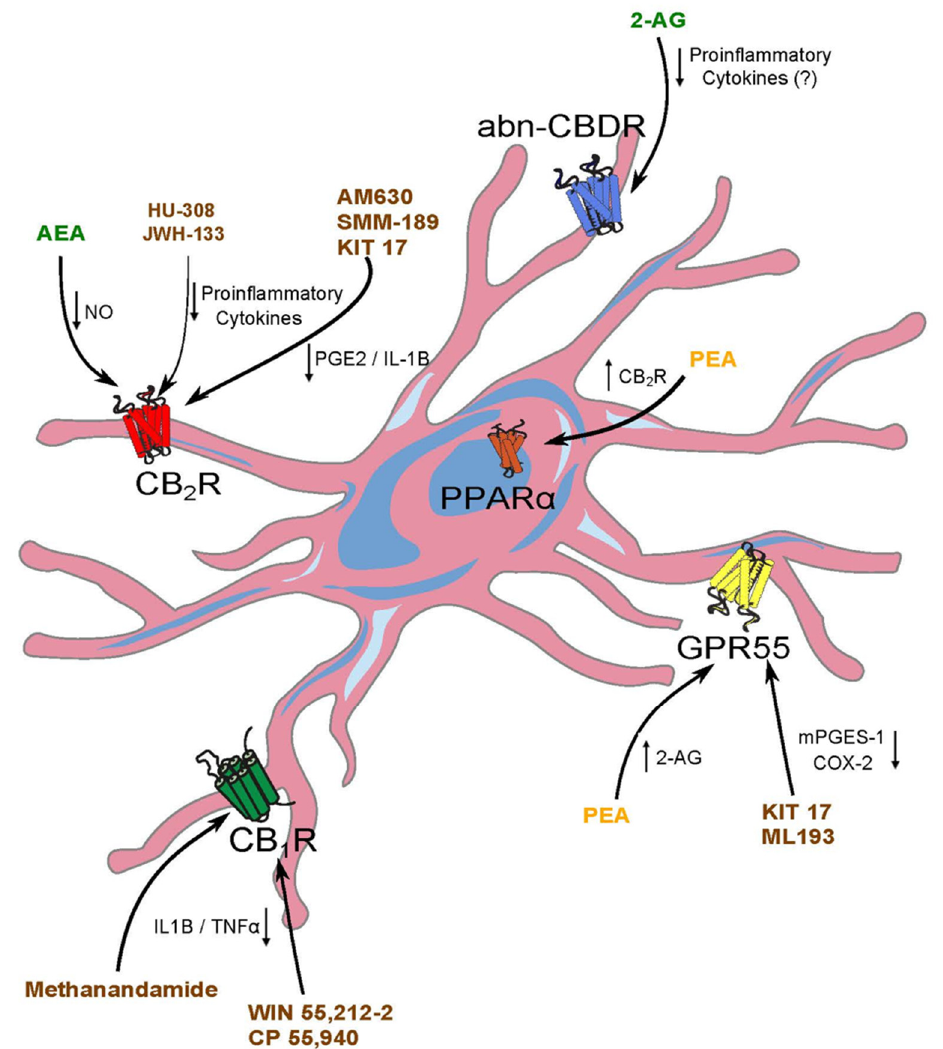
Figure 1. Schematic representation of the interactions of (endo)cannabinoids and synthetic cannabinoid compounds with microglia in the context of epilepsy and neuroinflammation. Endocannabinoids (green) interact with CB 2 receptors and other non-classical receptors (GPR55, PPAR and abn-CBDR). Fatty acid amides, such as PEA, interact with non-classical receptors (yellow), while synthetic cannabinoid effects (brown) involve mainly CB 1 and CB 2 receptors.